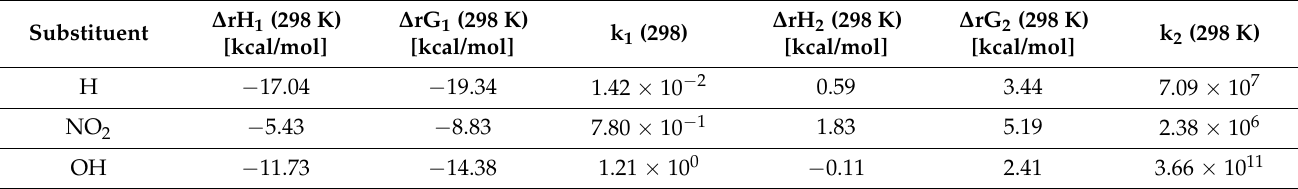
Table 9. Thermodynamic parameters for the keto-enol reaction of 1,8-dihydroxy-9-anthrone with participation of